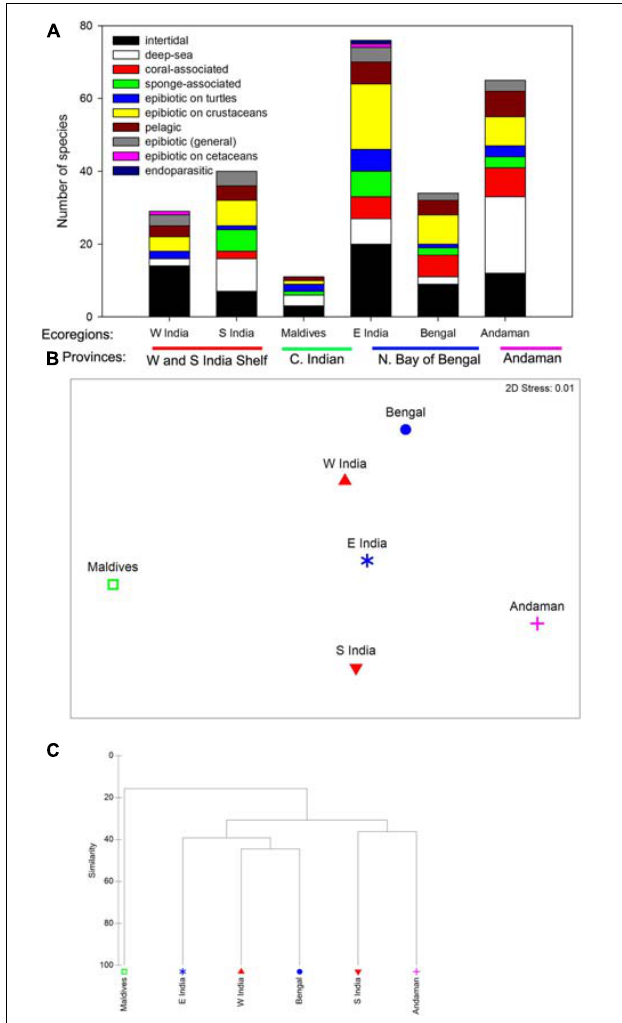
FIGURE 2 | (A) Species richness of barnacles from different life styles/habitats in different ecoregions and provinces. For clarity, names of ecoregions were abbreviated. W India – Western India Ecoregion, S India – Southern India and Sir Lanka ecoregion, Maldives – Maldives ecoregion, Bengal – Bay of Bengal ecoregion, Andaman – Andaman and Nicobar Islands ecoregion. (B) nMDS plot on the ordination of ecoregions based on species assemblage data. (C) Cluster analysis on the similarity of species assemblages among